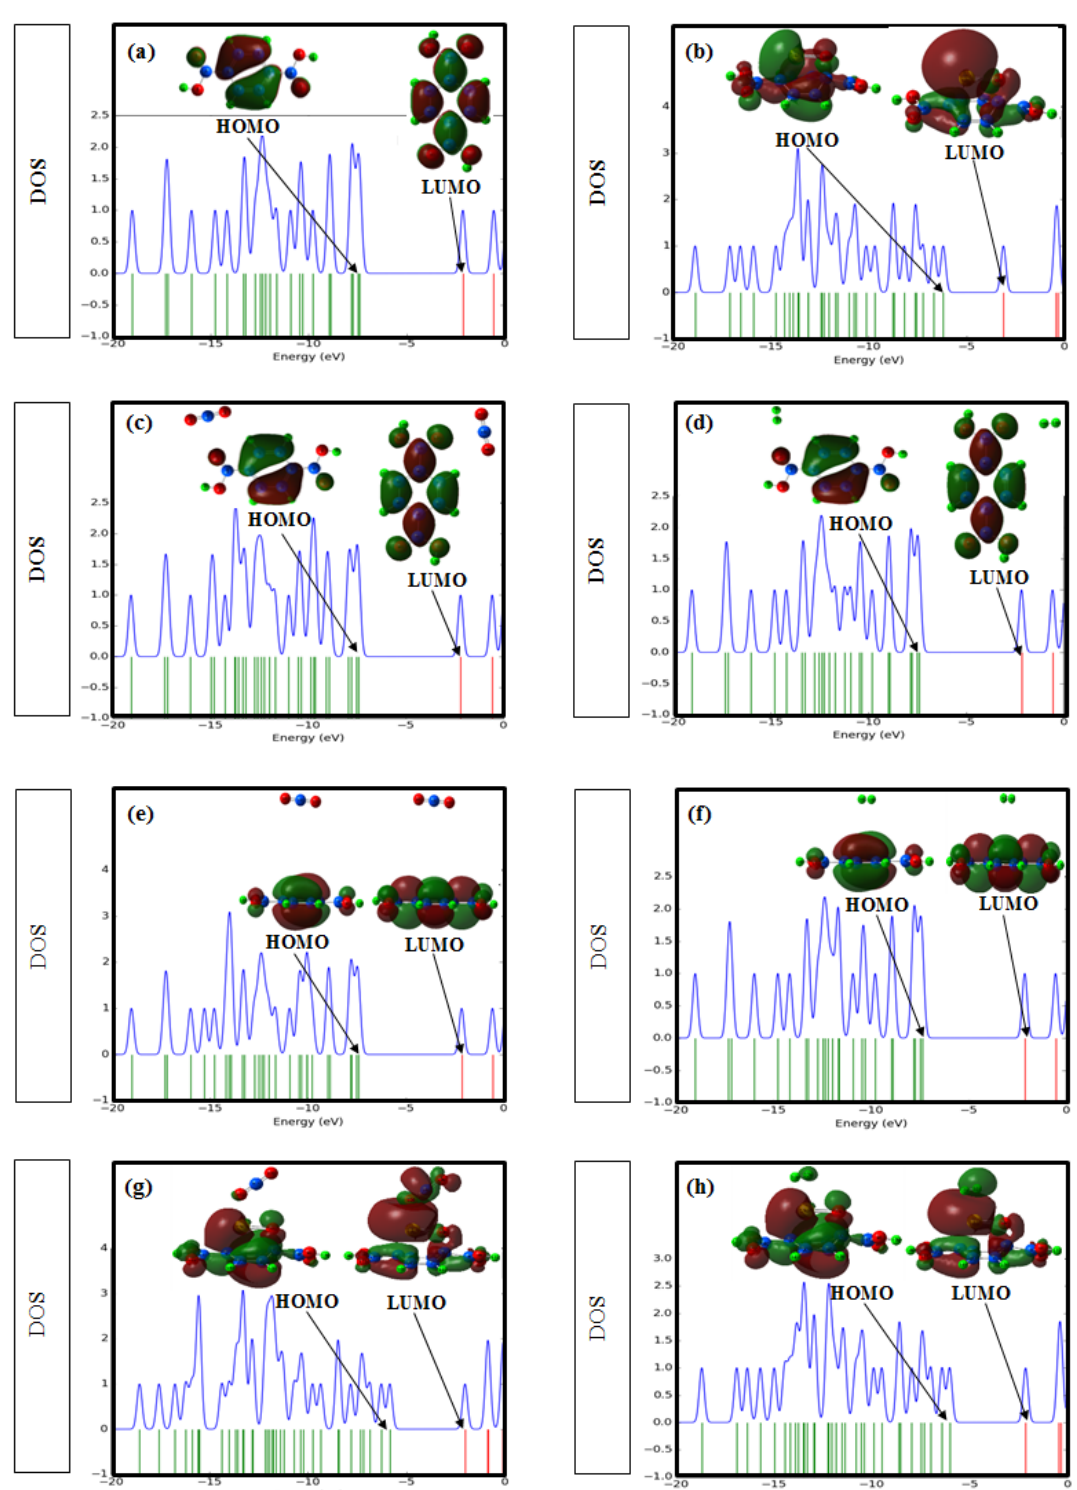
Fig. 6: Electron density of HOMO-LUMO and DOS of (a) pristine H